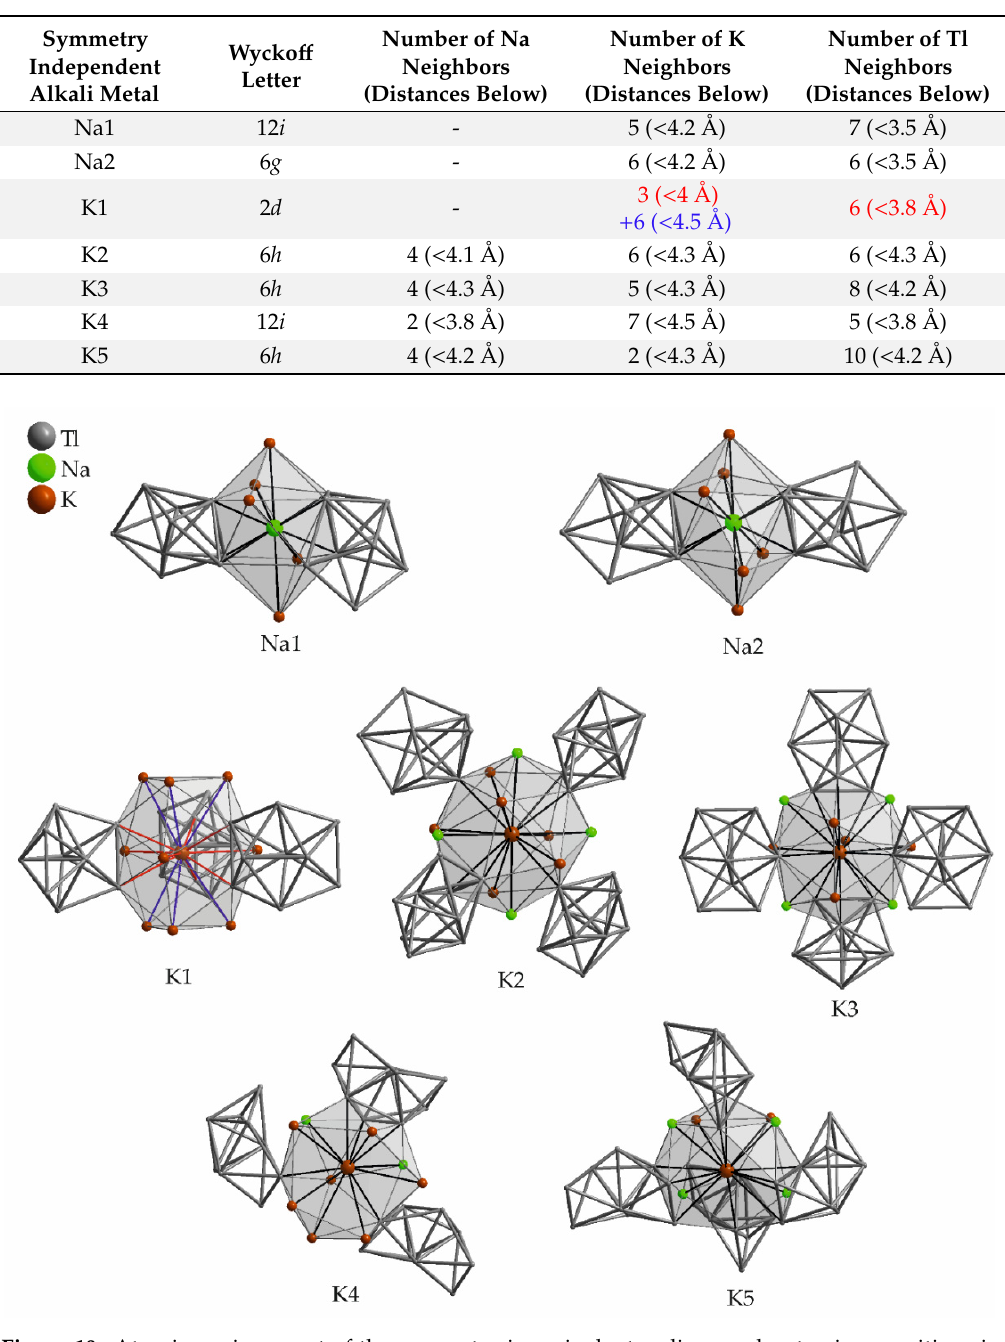
Table 12. Surrounding atoms of the symmetry inequivalent alkali metal positions in Na 9 K 16 Tl 25.25 (space group P 6 3 / m ). The color-coding refers to the color of the contacts in Figure 10.